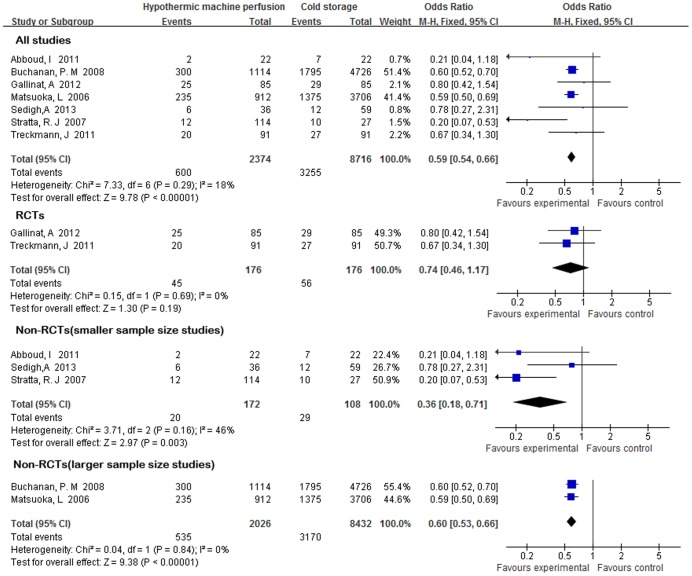
DGF rates for ECD kidneys preserved by HMP versus CS.